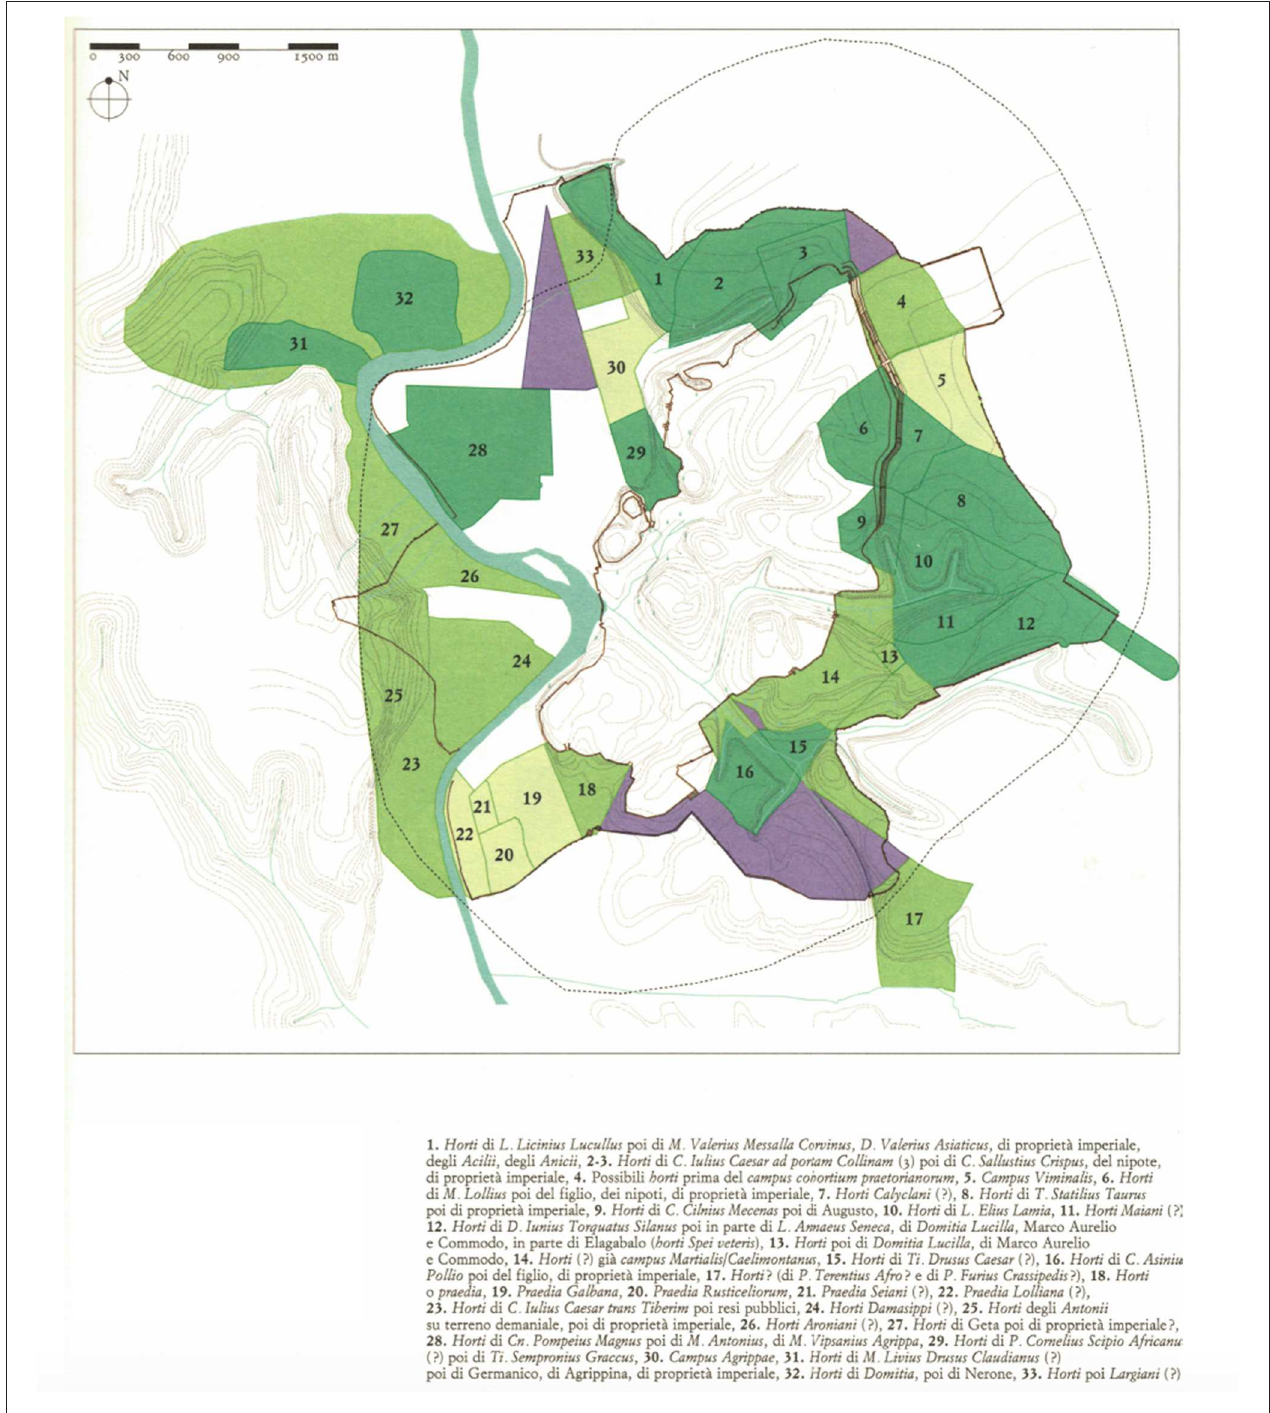
FIGURE 9 | The horti of Rome by the Imperial period. Dark green plots represent (possible) horti created in the late Republic or Augustan period, lighter green plots represent (possible) horti created in the Imperial period, yellow-green plots represent fields, purple plots represent funerary areas (Capanna, 2012: tav. III in Carandini, A. (ed.) (2012) Atlante di Roma Antica: Biografia e Ritratti della Città . Milan: Electa © Sapienza Università di Roma. Reproduced with permission).